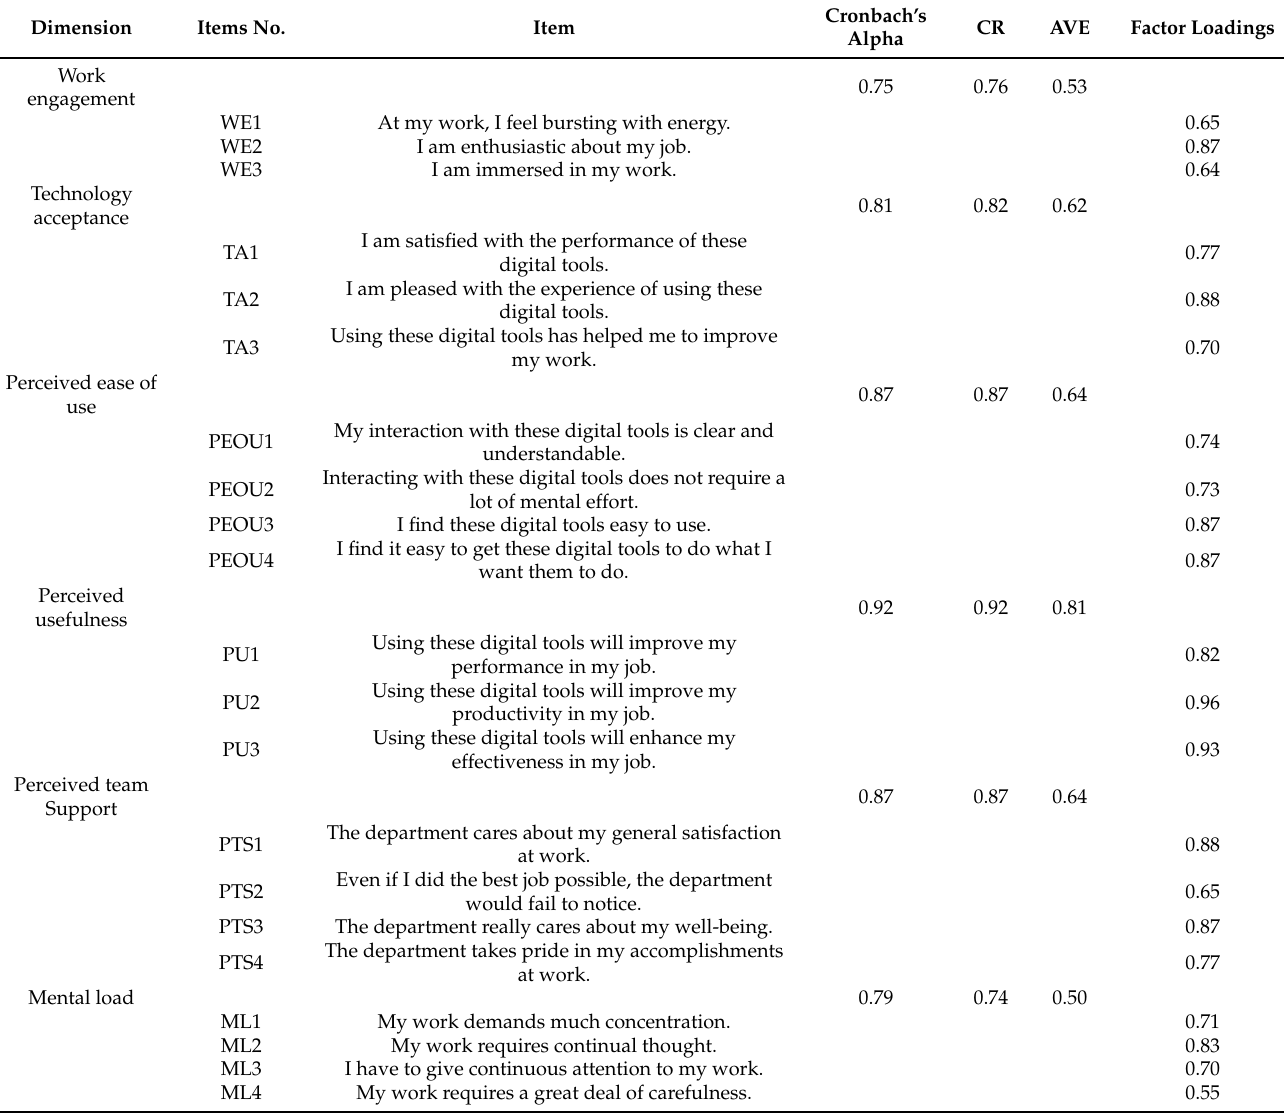
Table 2. Internal consistency and convergent validity of the